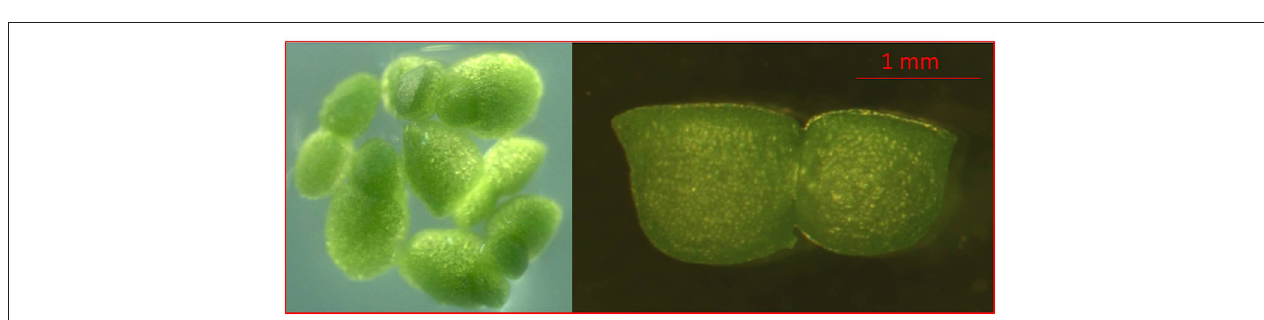
FIGURE 1 | Images of characteristic morphological features of Wolffia arrhiza . Dorsal view showing several flat-topped, dark green plants and side view of W. arrhiza budding plant showing flattened, dorsal surface of daughter plant.